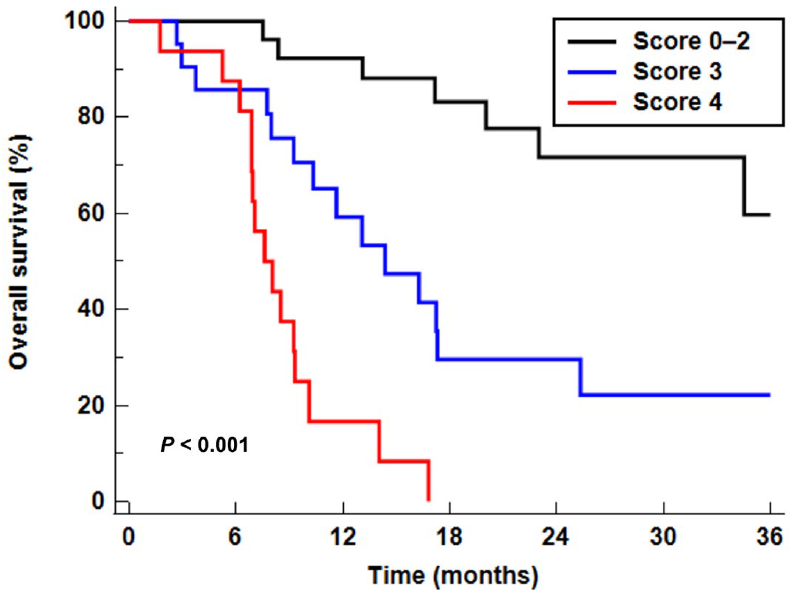
Figure 3. Kaplan–Meier curves for OS according to the PET/CT scoring system. To further evaluate the ability of PET/CT scoring system in prognostic stratification according to clinical TNM stage and treatment, the study patients were classified into two subgroups based on clinical TNM stage (stage I–II vs. stage III–IV) and treatment (surgical resection vs. other treatments). Afterward, the prognostic significance of the PET/CT scor- ing system was assessed in those subgroups (Table 5). In all subgroup analyses, patients with scores of 3 and 4 showed significantly worse OS than those with scores 0–2 ( p < 0.05), indicating the good prognostic value of the stratification system independent of tumor stage and treatment. The C-index of the combination of clinical TNM stage and PET/CT scoring system in predicting OS was 0.827 (95% CI, 0.713–0.910).